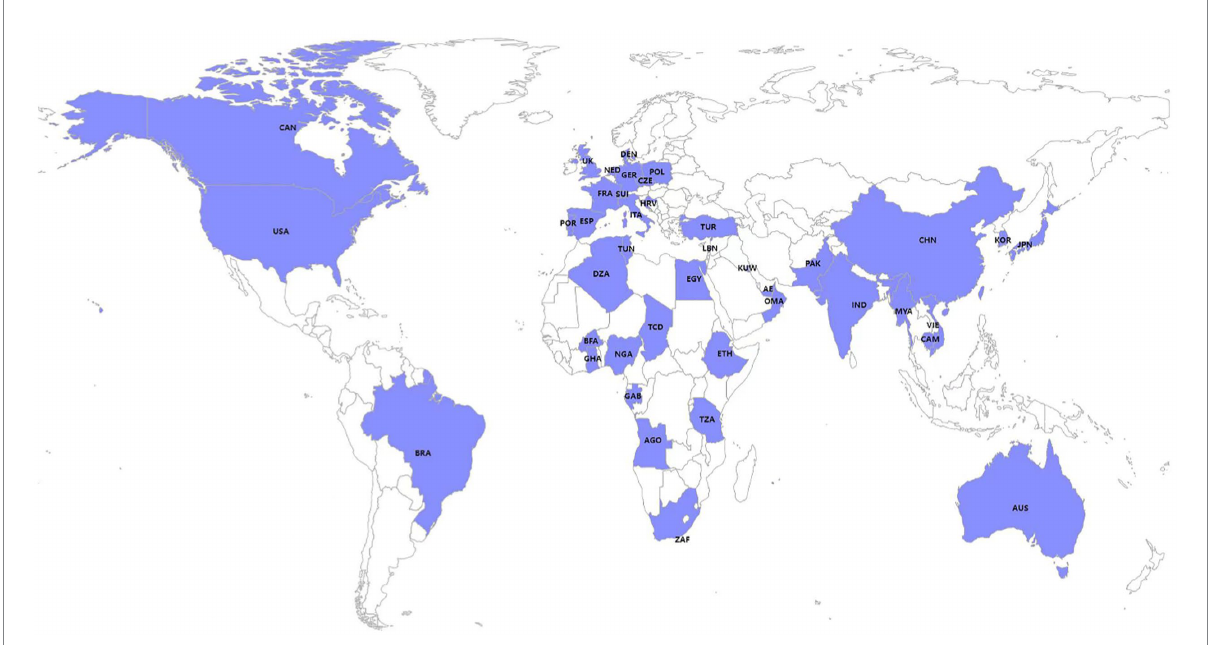
FIGURE 1 Global distribution of published strains harboring IncX3 plasmids included in this